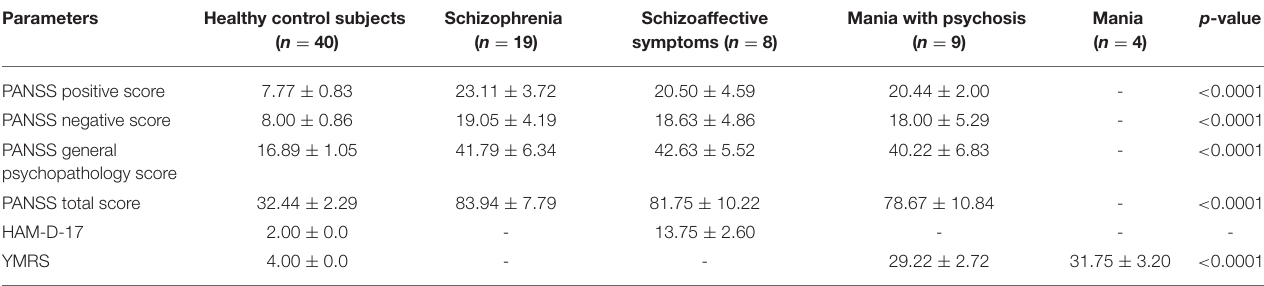
TABLE 5 | Psychiatric evaluation of healthy control subjects vs. test group, i.e., patients with cannabis use and psychotic symptoms (schizophrenia, schizoaffective symptoms, mania with psychosis, and mania). Parameters Healthy control subjects ( n =